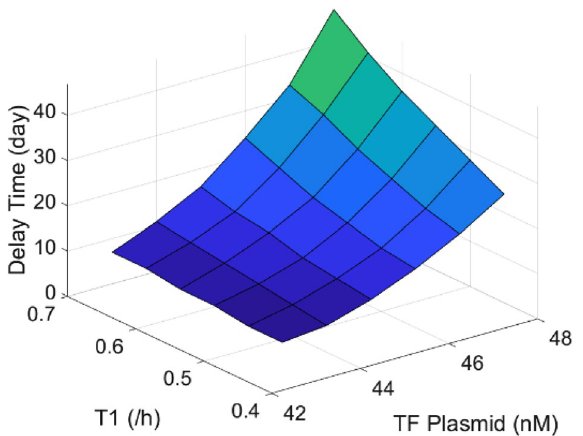
Figure 4. Tunable delay time. Delay time is highly tunable with different promoter for TF (T1 = 0.45/h, 0.5/h, 0.55/h, 0.6/h, 0.65/h, 0.7/h) or plasmid dose (n1 = 43 nM, 44 nM, 45 nM, 46 nM, 47 nM, 48 nM).